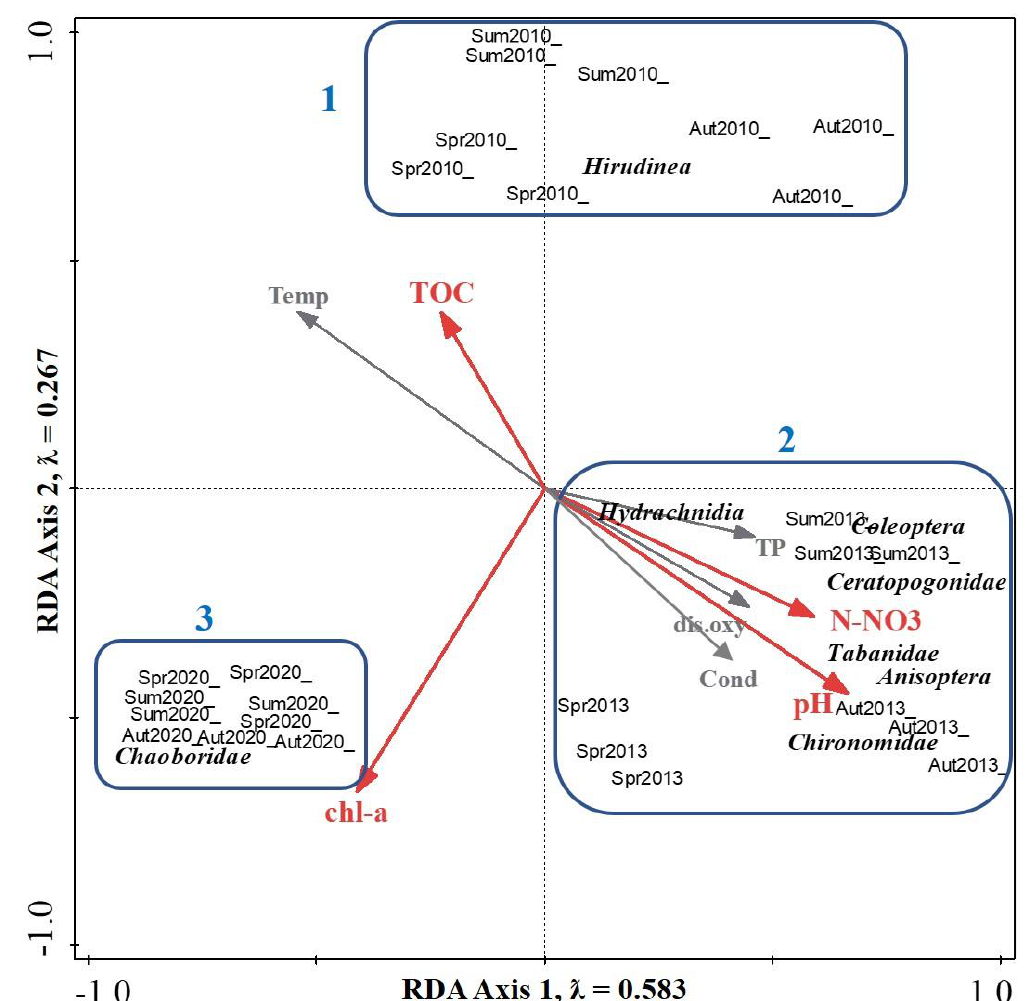
Figure 4. RDA triplot showing macroinvertebrate taxa, environmental variables, and samples. Solid red arrows indicate significant variables based on Monte Carlo permutation test ( p < 0.05). Spr2010, Sum2010, Aut2010-samples collected in spring, summer, and autumn 2010; Spr2013, Sum2013, Aut2013-samples collected in spring, summer, and autumn 2013; Spr2020, Sum2020, Aut2020-samples collected in spring, summer, and autumn